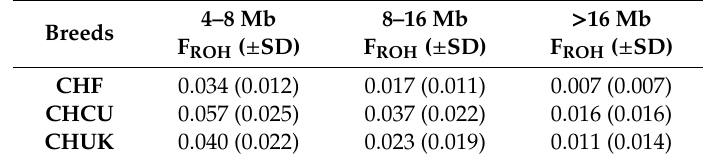
Table 1. Genomic inbreeding (F ROH ) according to three intervals (Mb) in three Charolais populations. CHCU: Charolais de Cuba; CHF: French Charolais; CHUK: British Charolais. 4–8 Mb 8–16 Mb Breeds